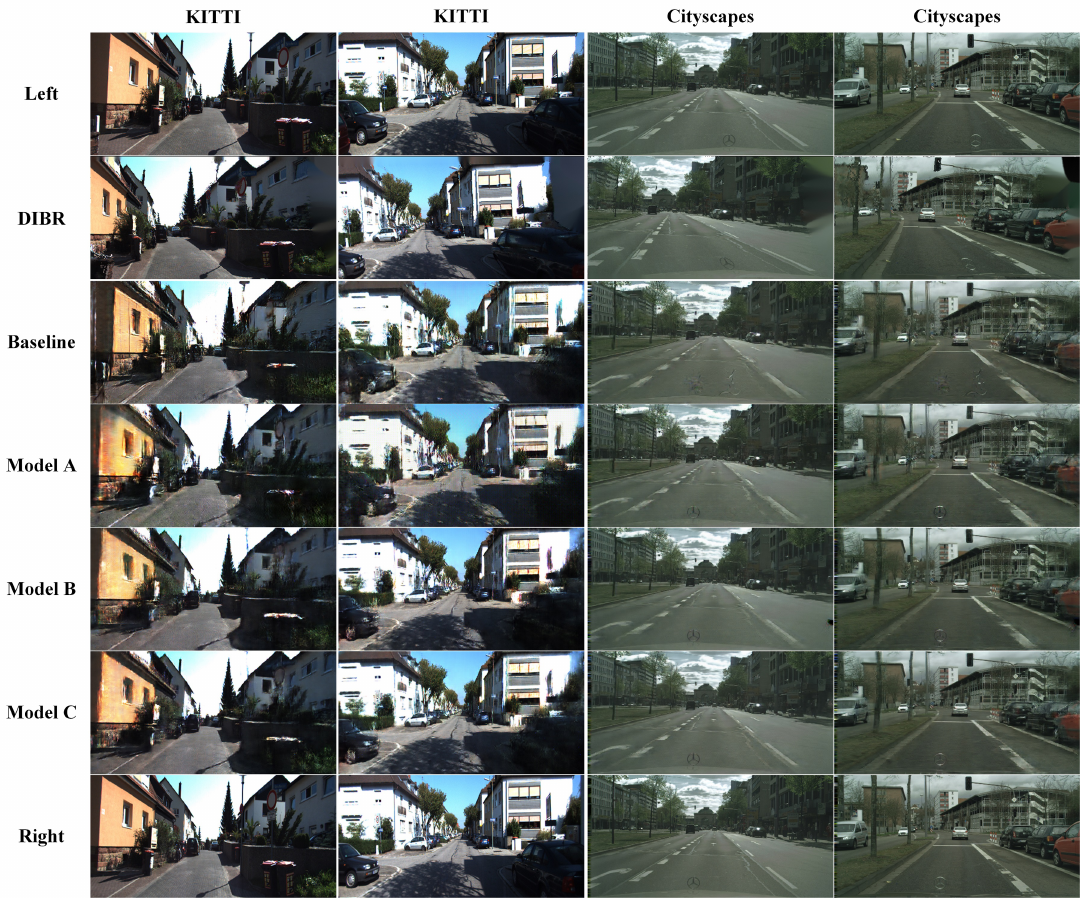
Figure 11. Right vision reconstruction. Left image is the input. Right image is the ground truth. In the experiment, the outputs of five methods are compared in KITTI dataset and Cityscapes